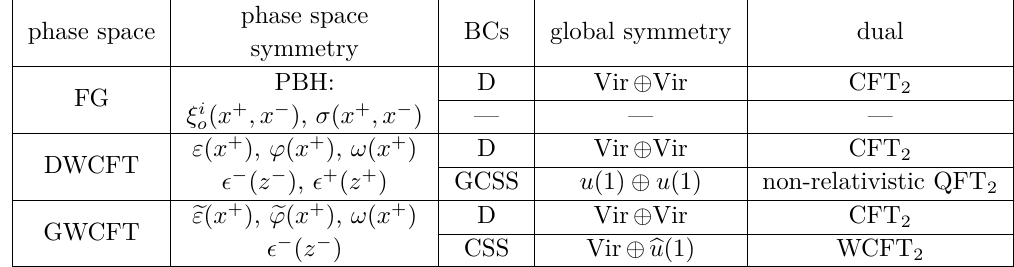
Table 2 . Summary of the three phase spaces we study in this paper: GWCFT ⊂ DWCFT ⊂ FG. For each case we list the phase space symmetries, which are independent of the choice of boundary conditions, as well as the global symmetry algebra corresponding to either Dirichlet (D) or Compère-Song-Strominger (CSS) boundary